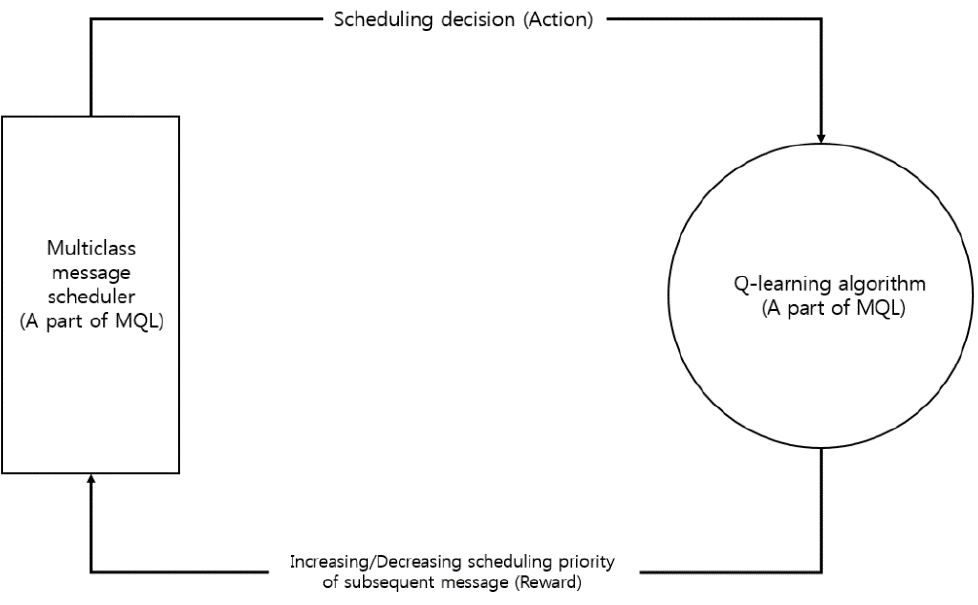
Figure 3. Q-learning algorithm.